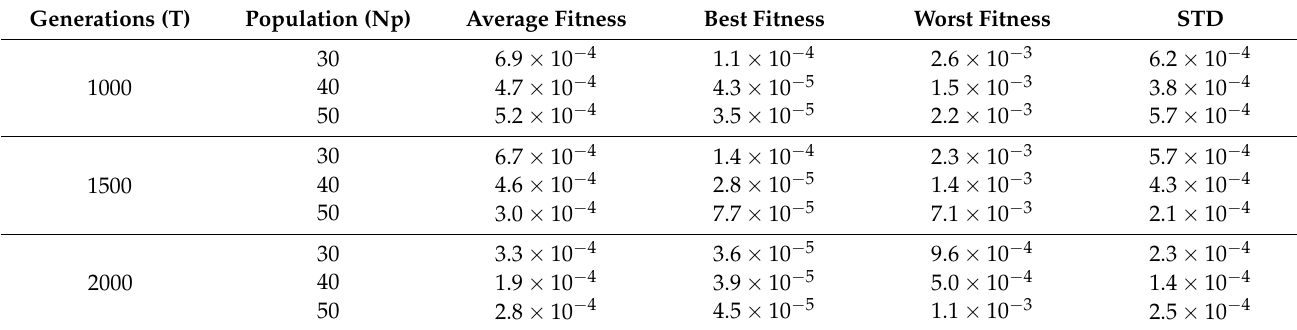
Table 10. AO parameter analysis for case 9.